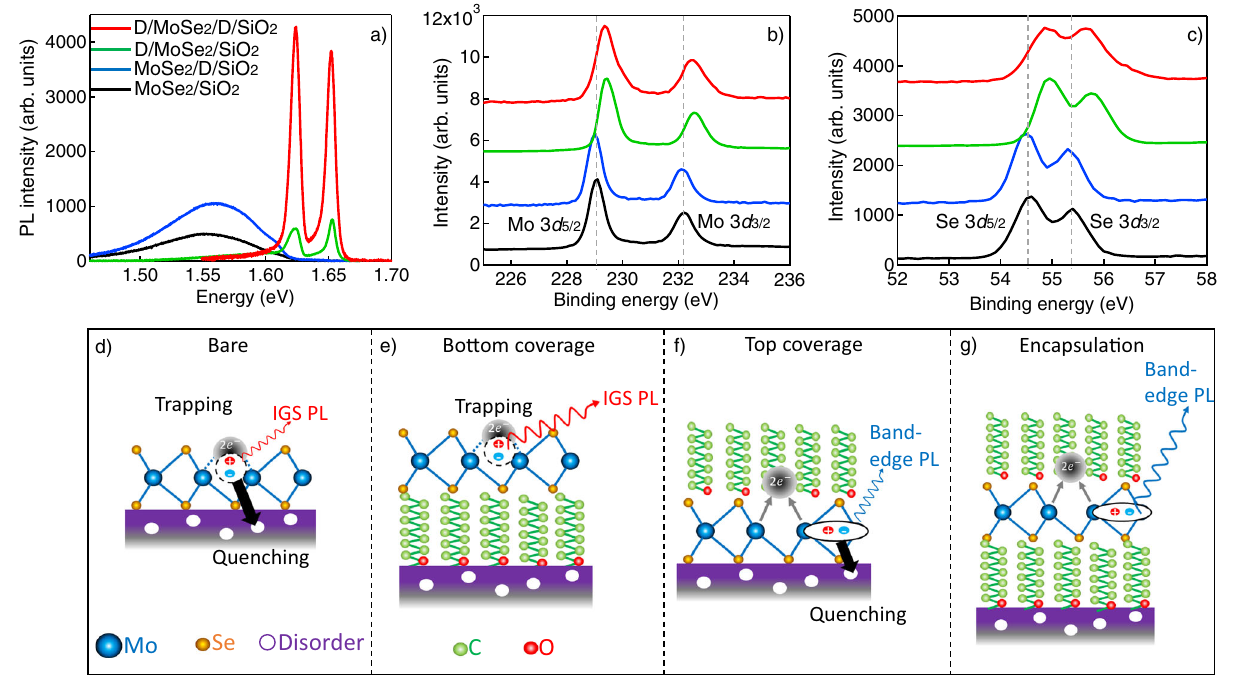
Fig. 3 | Proposed mechanisms of optical property enhancement due to dode- canol encapsulation. a Comparison of PL spectra of bare (black), only bottom- covered (blue), only top-covered (green), and both top and bottom-covered (red) MoSe 2 MML. b , c Comparison of X-ray photoelectron spectroscopy (XPS) spectra of ( b ) Mo 3 d core levels and ( c ) Se 3 d core levels of the same four MMLs as in ( a ), showing blueshifts when there is top-coverage of dedocanol (green and red).